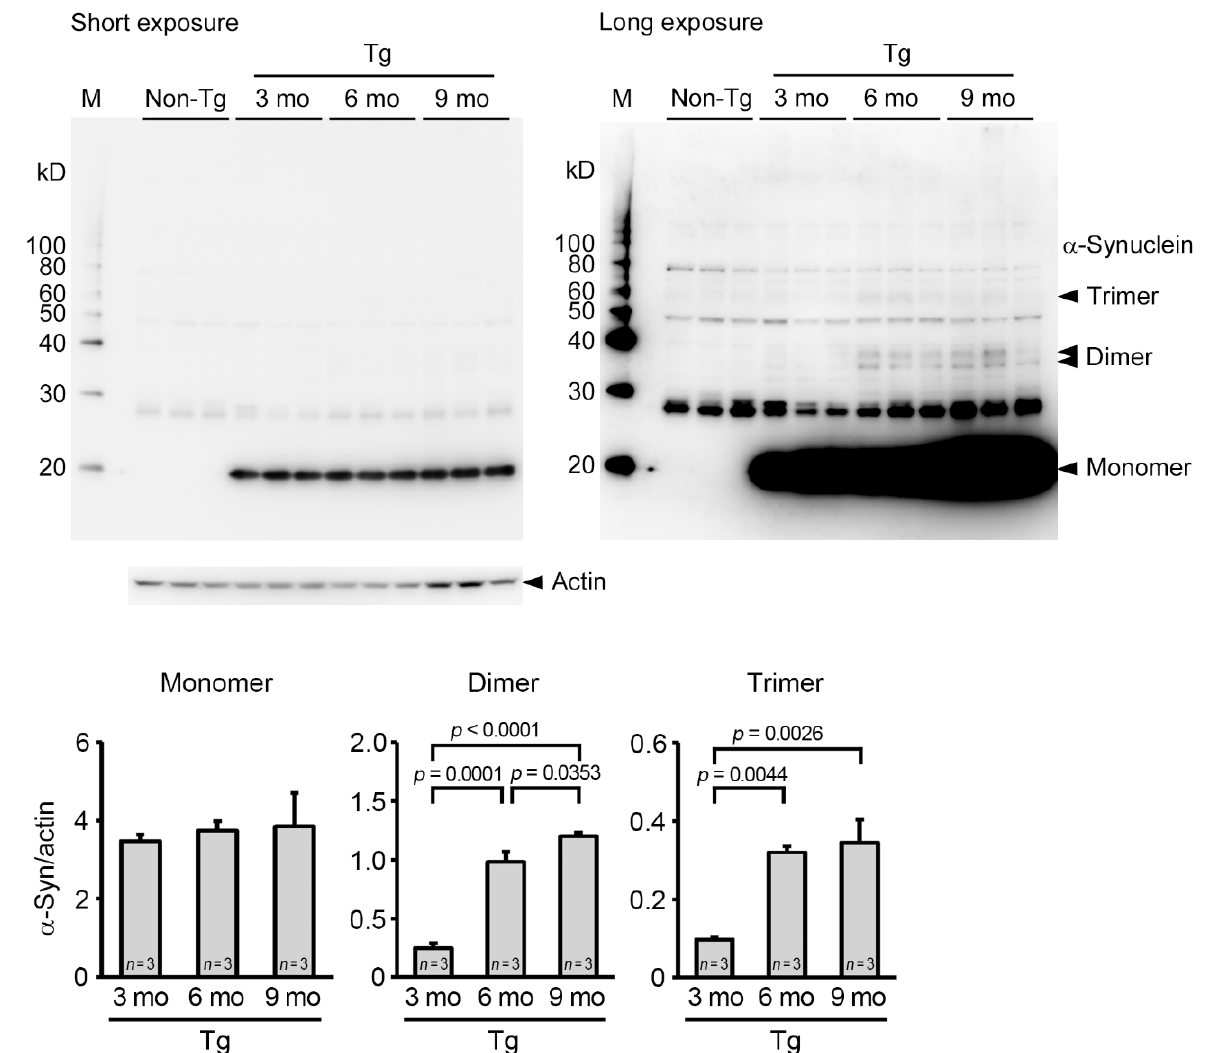
Figure 3. Accumulation of α -synuclein oligomers in Tg mice. Brain soluble fractions were prepared at 3, 6, and 9 months old (mo) and examined for α -synuclein oligomers by Western blotting. Non-Tg littermate samples were obtained at 6 months. α -Synuclein dimers and trimers were significantly increased at 6 months. M, MagicMark XP Western Protein Standard (Invitrogen, Carlsbad, CA, USA).